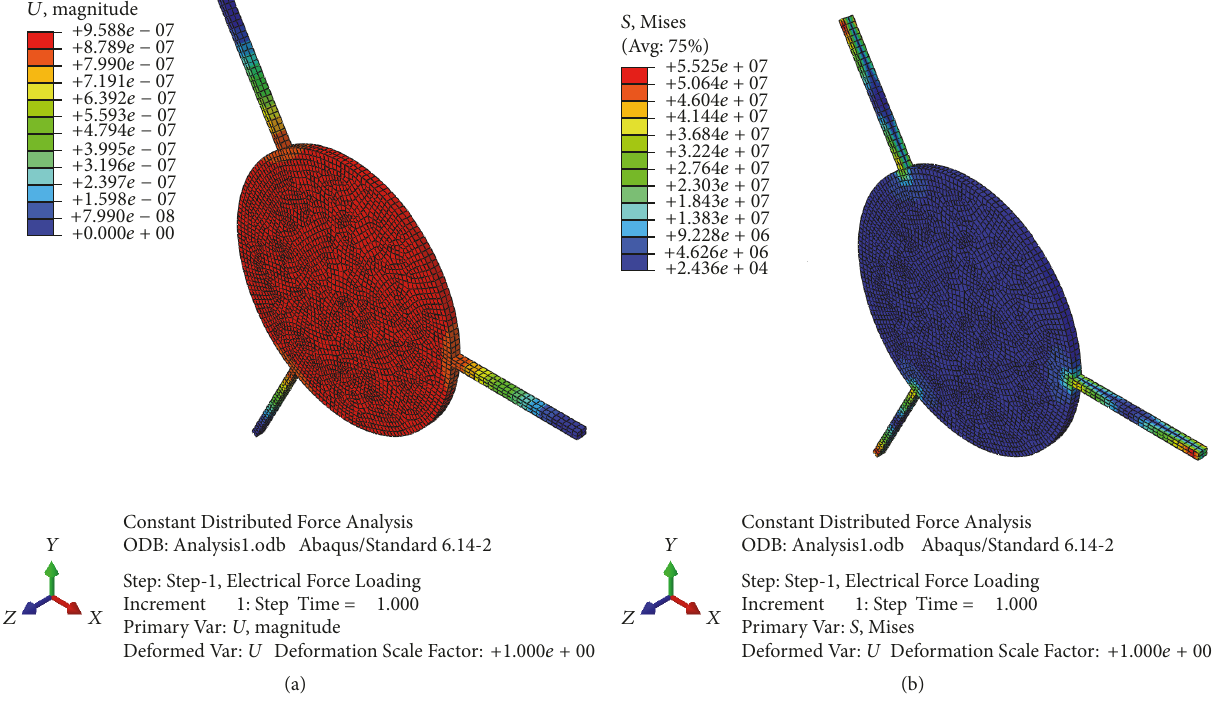
Figure 2: Tension and displacement: (a) displacement of the seeds in top plate; as it is seen, the desired displacement, 67 𝜇 m, is not attained due to simplifying assumptions in modeling; (b) stress distribution on top plate due to the applied electrostatic